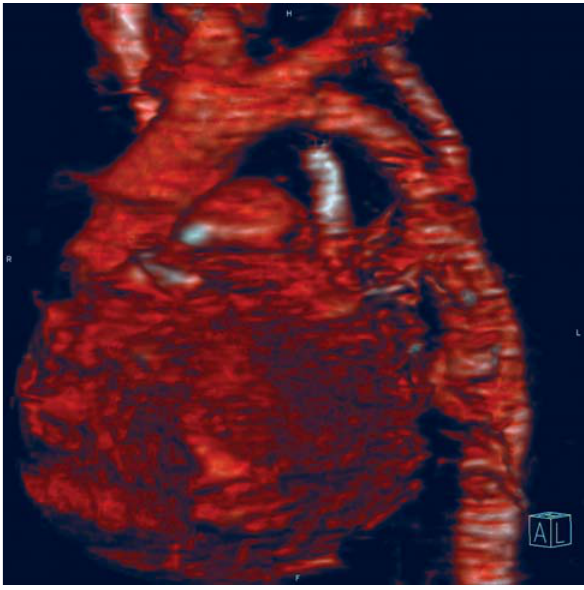
Fig. 1 - Coarctação aórtica pré-ductal com hipoplasia do